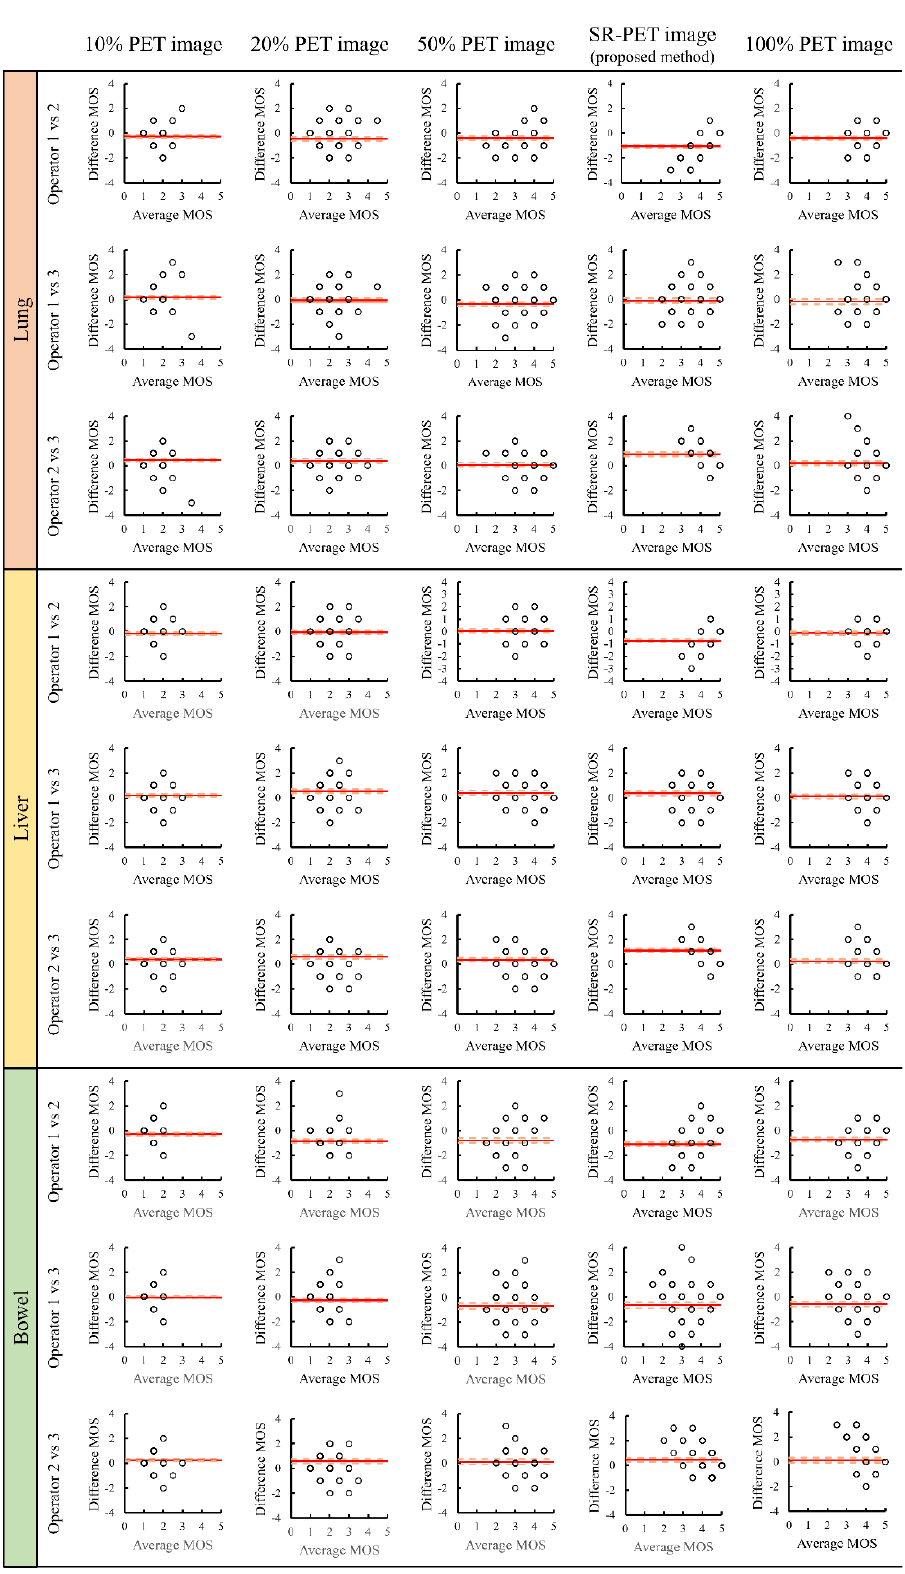
Figure 4. Bland–Altman plot showing the inter-operator difference in MOS for each image set. The red solid line denotes the mean of the difference, and the dashed line denotes the 95% limits of agreement. PET: Positron emission tomography, SR-PET: Super-resolved PET, MOS: Mean opinion score.